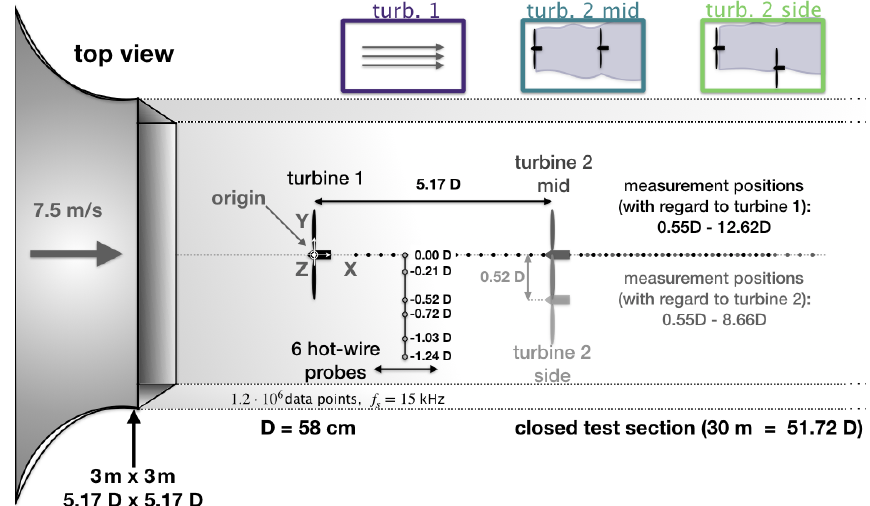
Figure 1. Setup (modified from Neunaber, 2019): a hot-wire array is used to measure the wakes of (1) a single turbine (plot color: dark purple), (2) a turbine exposed to the wake of an upstream turbine (plot color: turquoise), and (3) the half-wake of an upstream turbine (plot color: